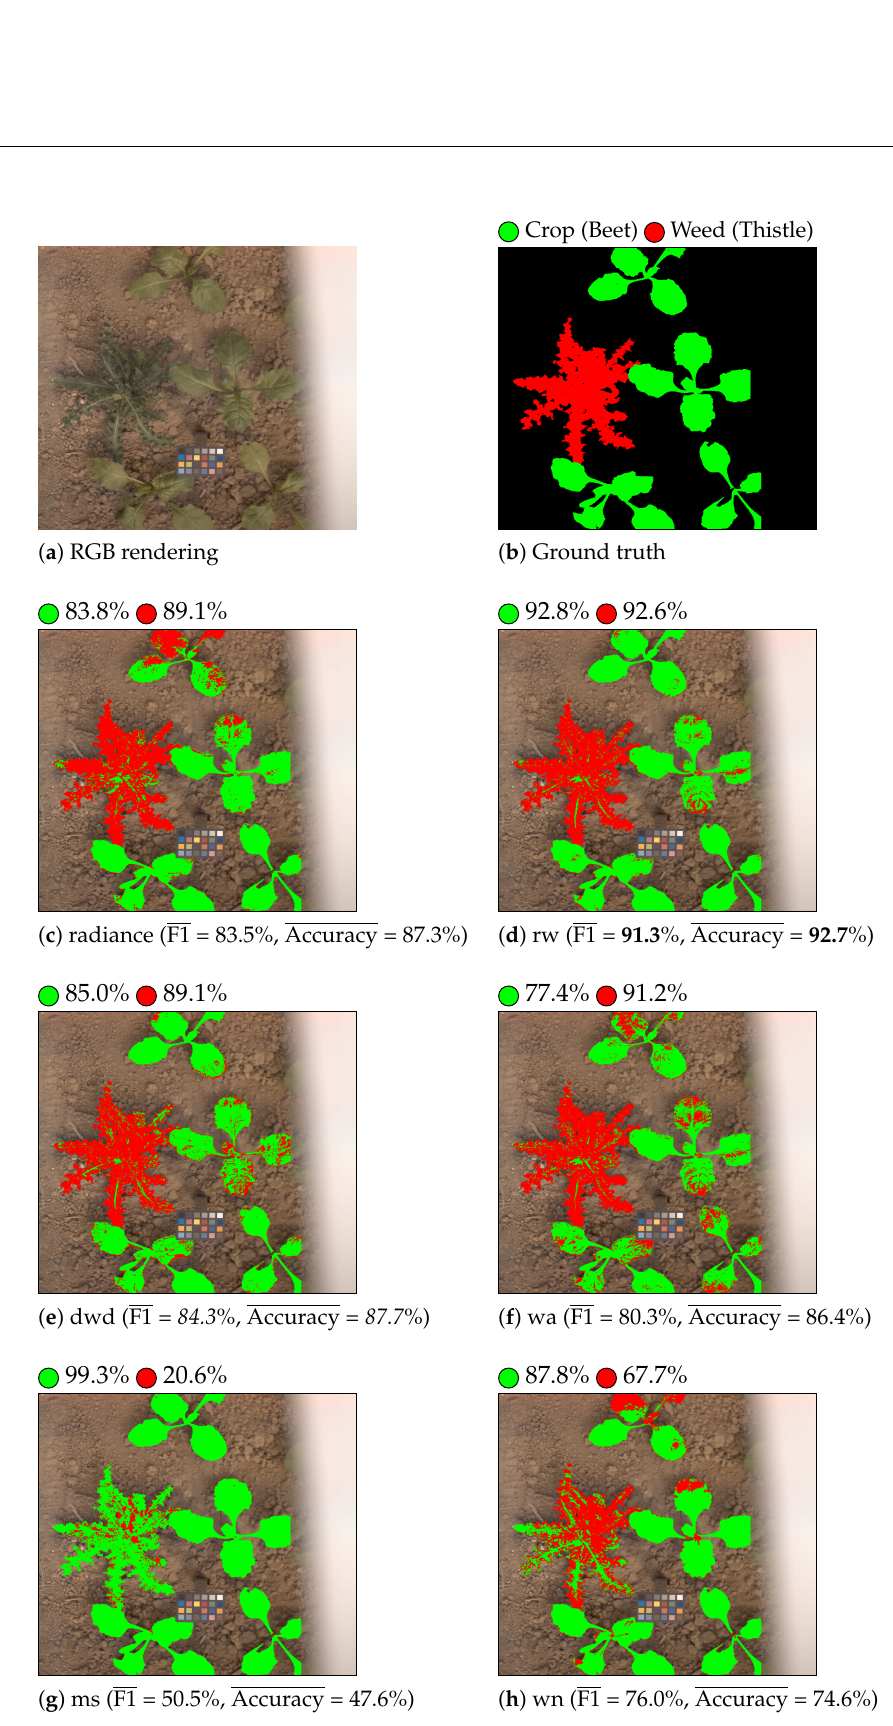
Figure 6. Crop/weed detection. Beet is displayed as green and weed as red. The per-class accuracy score is displayed near each colored circle (class label) for each considered